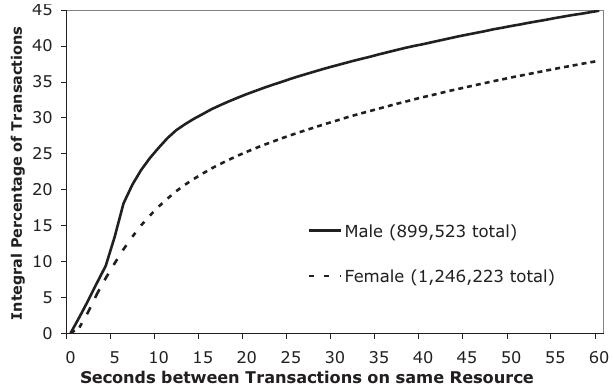
FIG. 5. Integral distribution of times between subsequent trans- actions on the same resource.